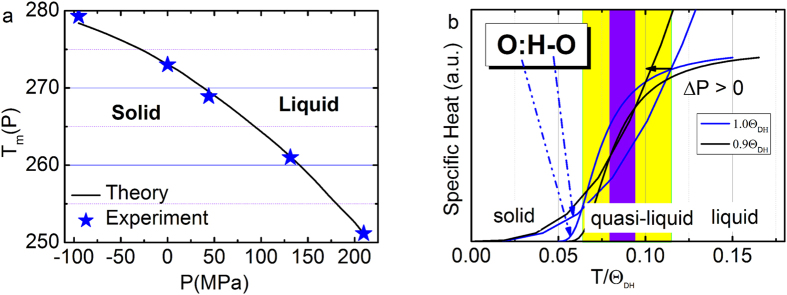
(a) Theoretical reproduction of the measured Tm(P) (−22 °C at 210 MPa;  + 6.5 °C at −95 MPa)32 profiles confirms that the EH dictates the Tm for ice melting with derivative of EH = 3.97 eV for bulk water18. (b) The superposition of the ηx(T) curves yields two crossing temperatures that defines the solid/quasisolid/liquid phase boundaries. The high temperature boundary corresponds to quasisolid melting and the lower to freezing. Compression/tension (ΔP > 0)/(ΔP < 0) disperses the boundaries simultaneously and reversely by modulating the ΘDx ∝ ωDx and Ex ∝ , depressing/elevating the Tm.